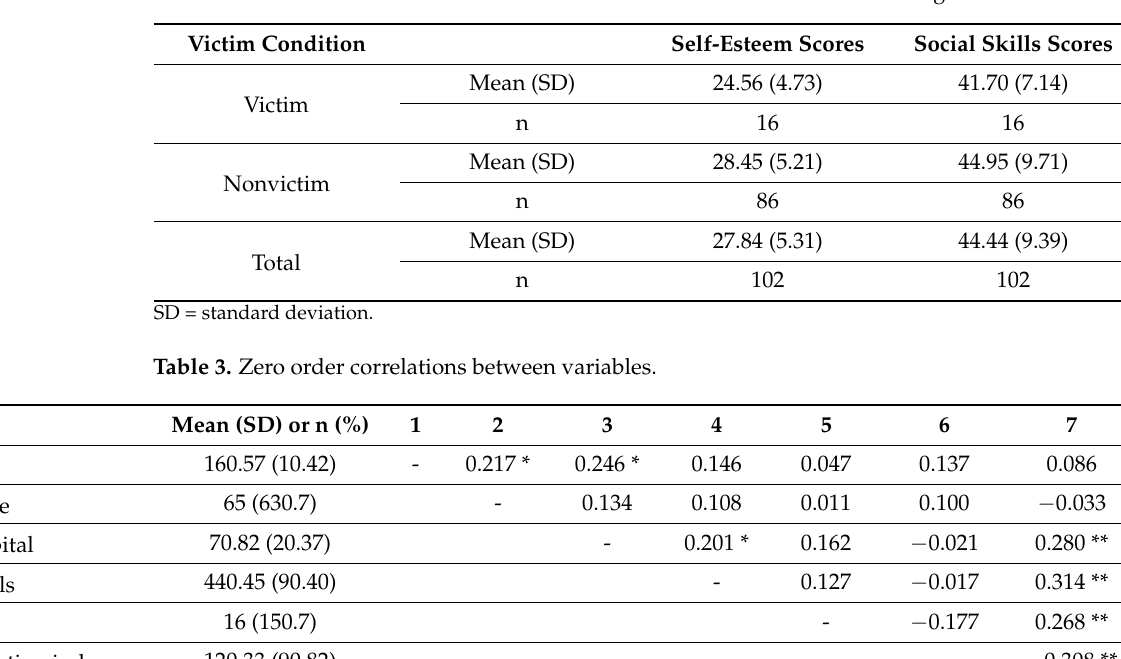
Table 2. Meanandstandarddeviationforself-esteemandsocialskillsscoresaccordingtovictimconditions.